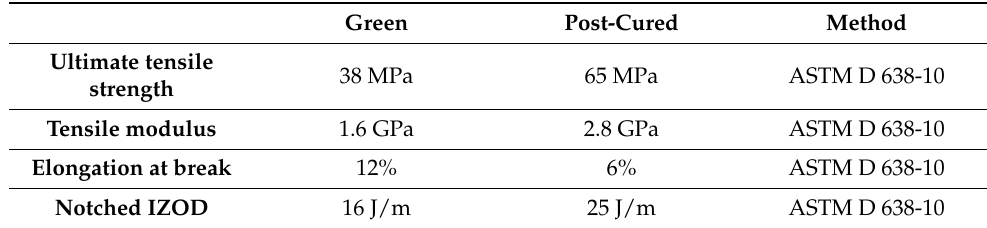
Table 2. Mechanical properties of the employed rigid resin (White V4), as declared by the producer. Source: Formlabs Materials